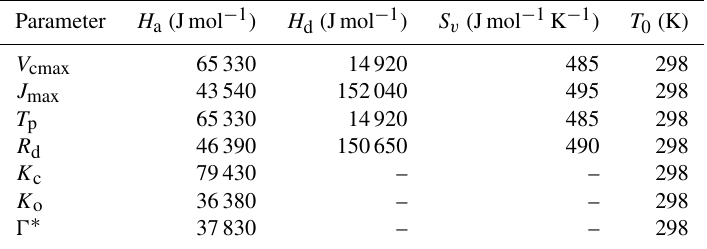
Table B1. C 3 temperature dependence functional parameters.